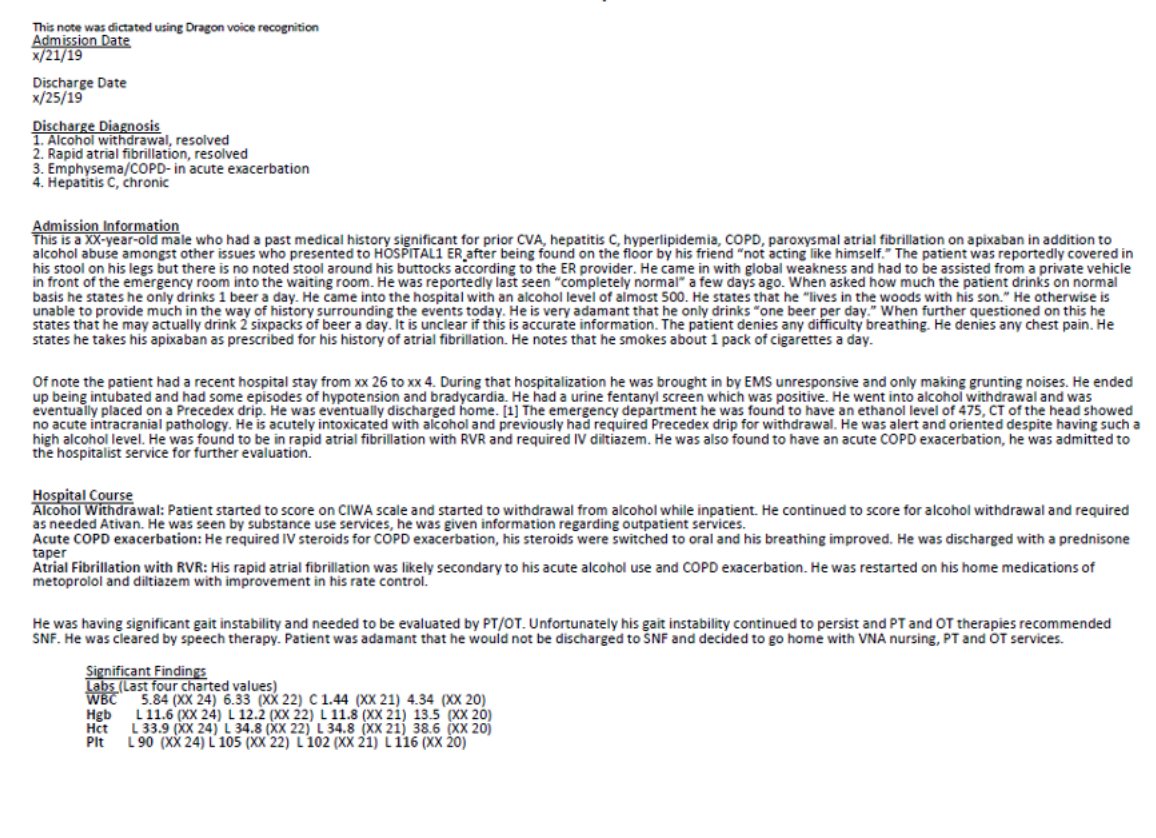
Figure 1. The top portion of a simulated discharge summary from hospital